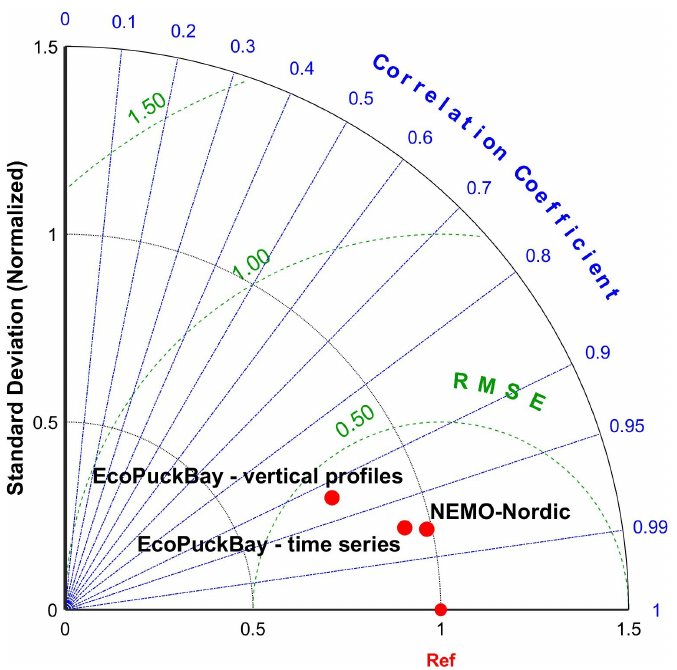
Figure 3. Taylor diagram for